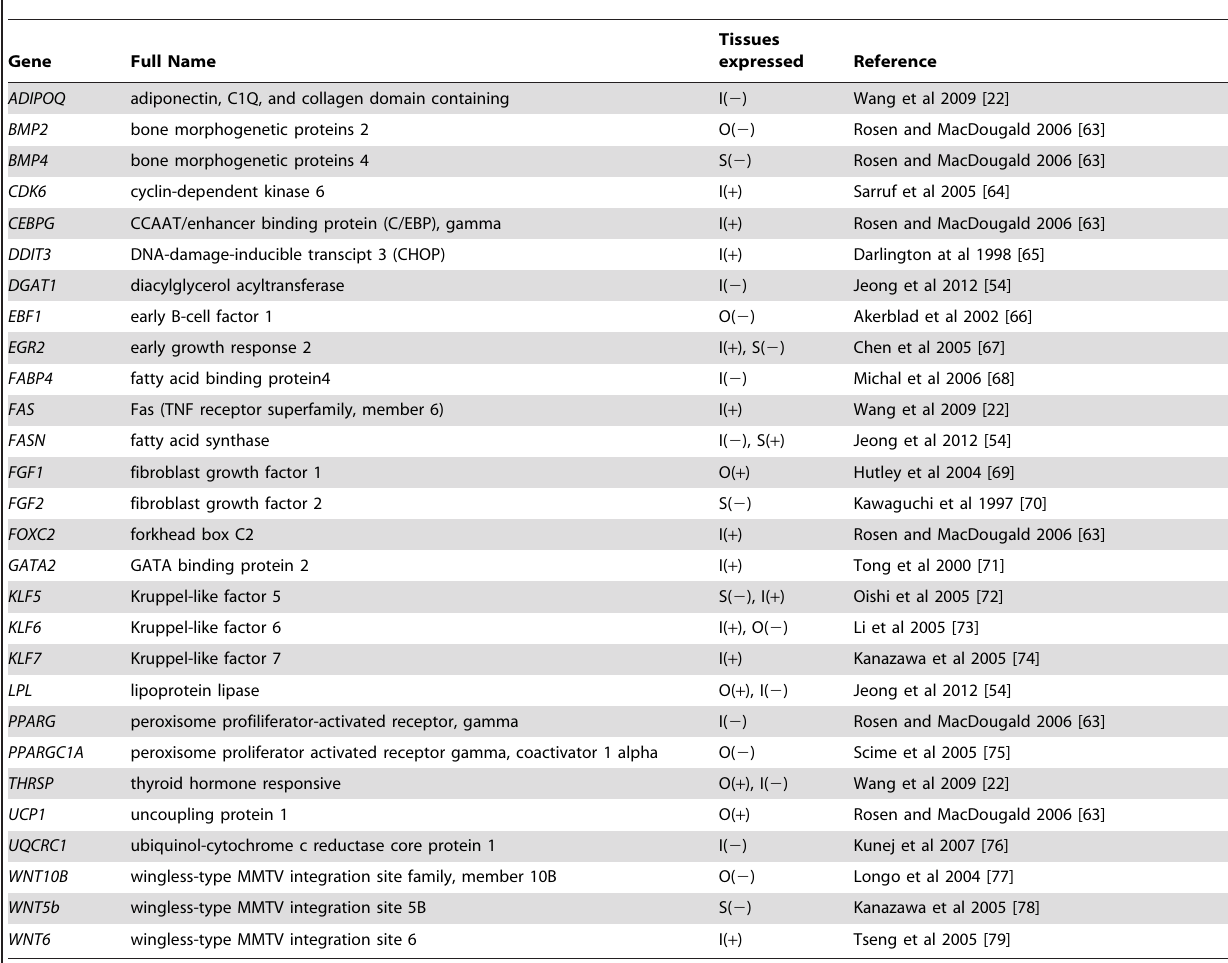
Table 2. Identified DEGs involving in adipogenesis, signaling pathway, and lipid metabolism.